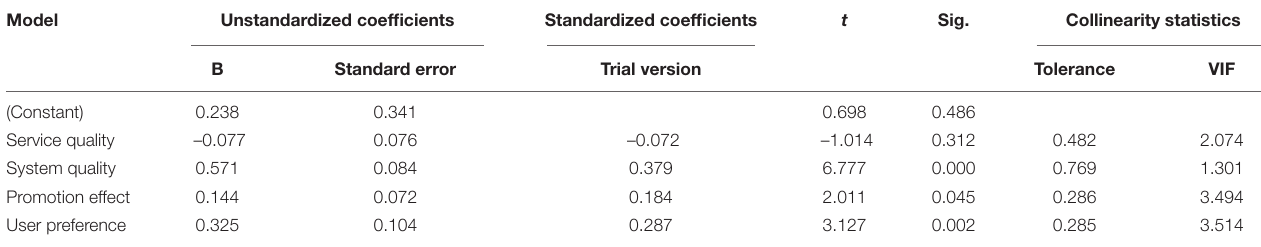
TABLE 3 | Multiple regression results.